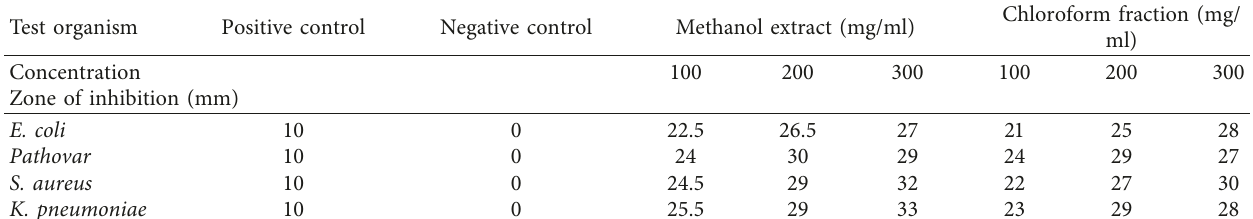
Table 1: Antibacterial activity of the methanol extract and chloroform fraction of N. distans .